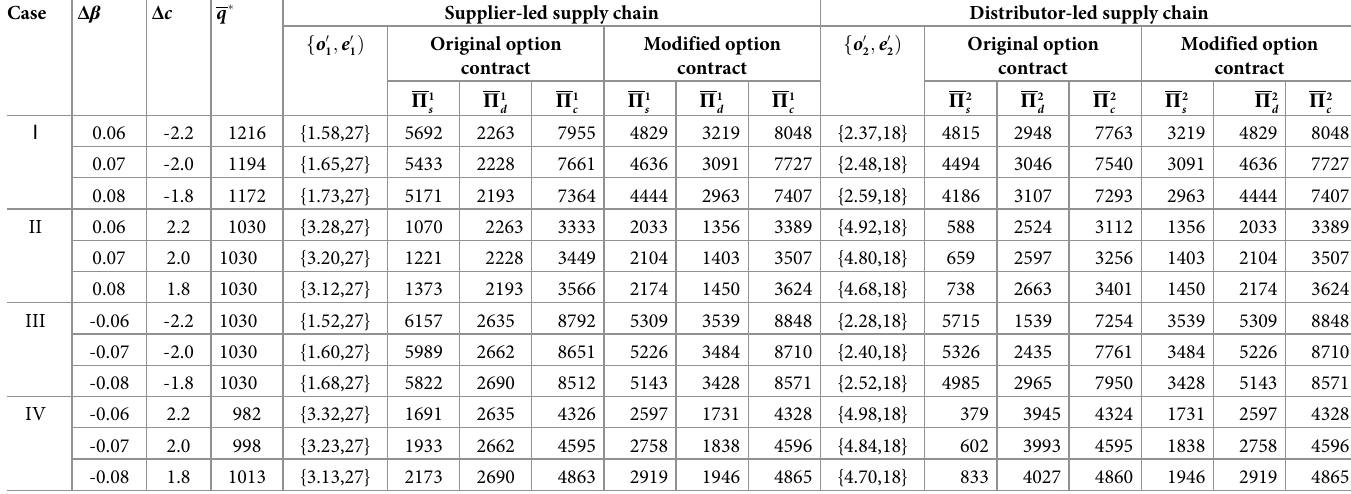
Table 1. The parameters, the decisions and the profits under